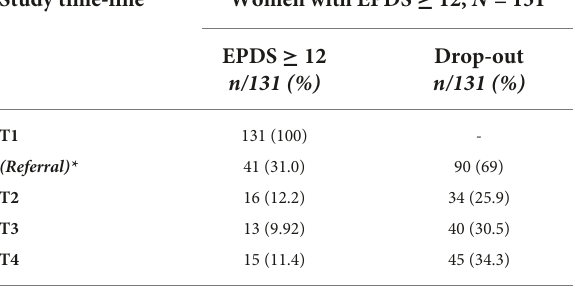
TABLE 6 Re-test and drop-out rates of women reporting EPDS total scores ≥ 12 at T1 (screening; N = 131).